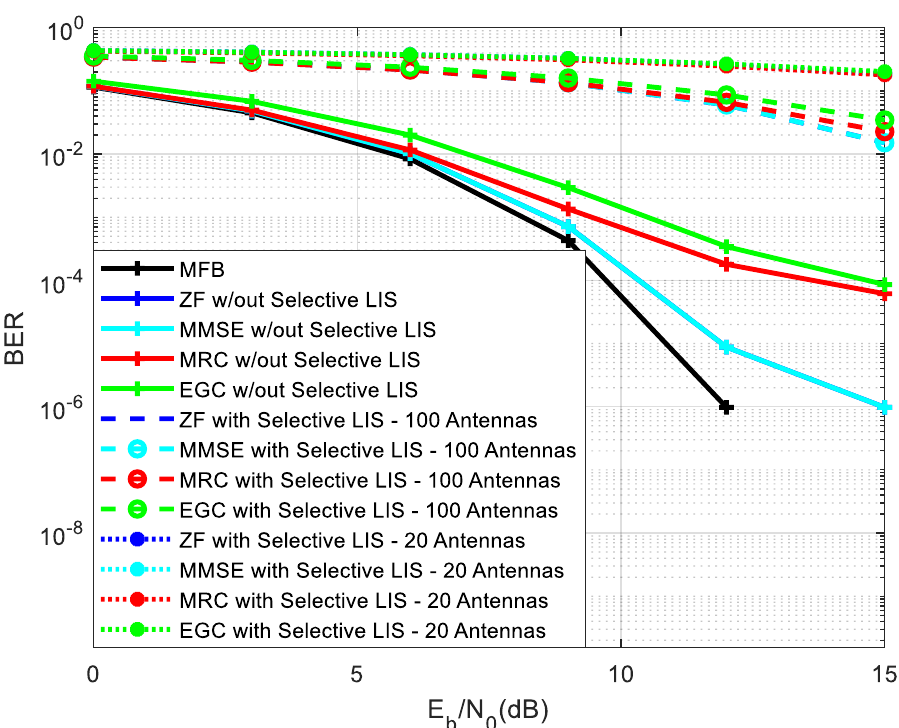
Figure 10. Results for 4X225 LIS System, with 5 users, without Selective LIS versus with Selective LIS (20 versus 100 antennas).